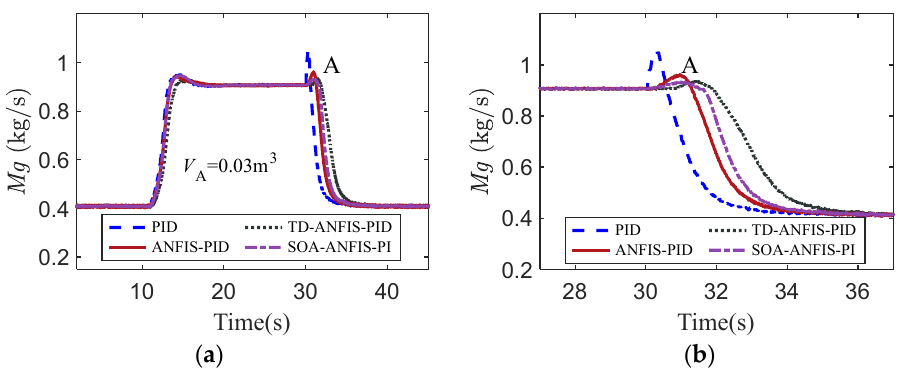
Figure 17. Comparison of anti-regulation suppression ability of various controllers ( a ) Gas flow response; ( b ) Gas flow response.